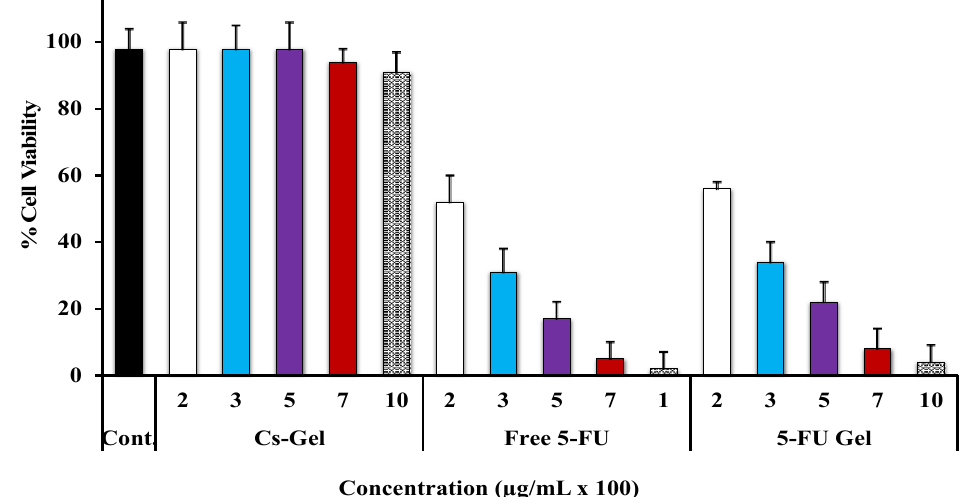
Figure 4. Cytotoxicity studies of 5-FU-loaded Cs/ β -GP + PL hydrogel on MCF-7 cells in comparison with either blank chitosan polymer or free drug solution, as a function of concentration (incubation period was fixed at 48 h). The obtained results are shown as the mean of three experiments ± SD.